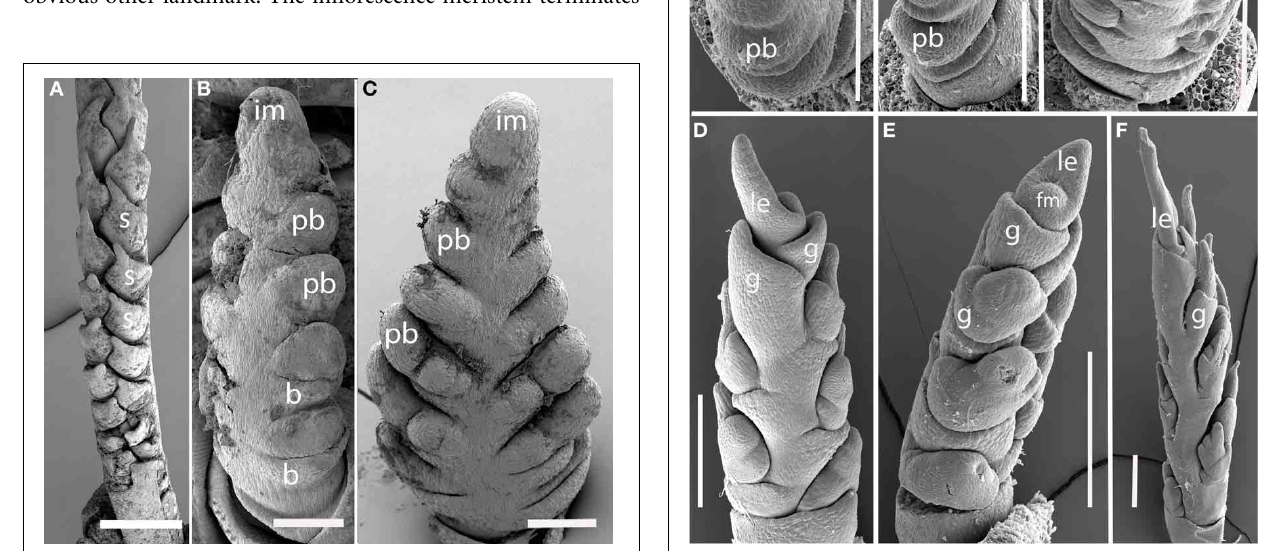
FIGURE 4 | Nardus (Nardeae) and Phaenosperma (Phaenospermateae). (A) Nardus stricta . Spikelets are two-ranked and unilateral. (B,C) Phaenosperma globosa . Primary branches are two-ranked and approximately distichous (C) , secondary branches form on the side facing the camera. s, spikelet; im, inflorescence meristem, pb, primary branch, b, bract, Scale bars: (A) , 500 µ m; (B,C) , 100 µ m.